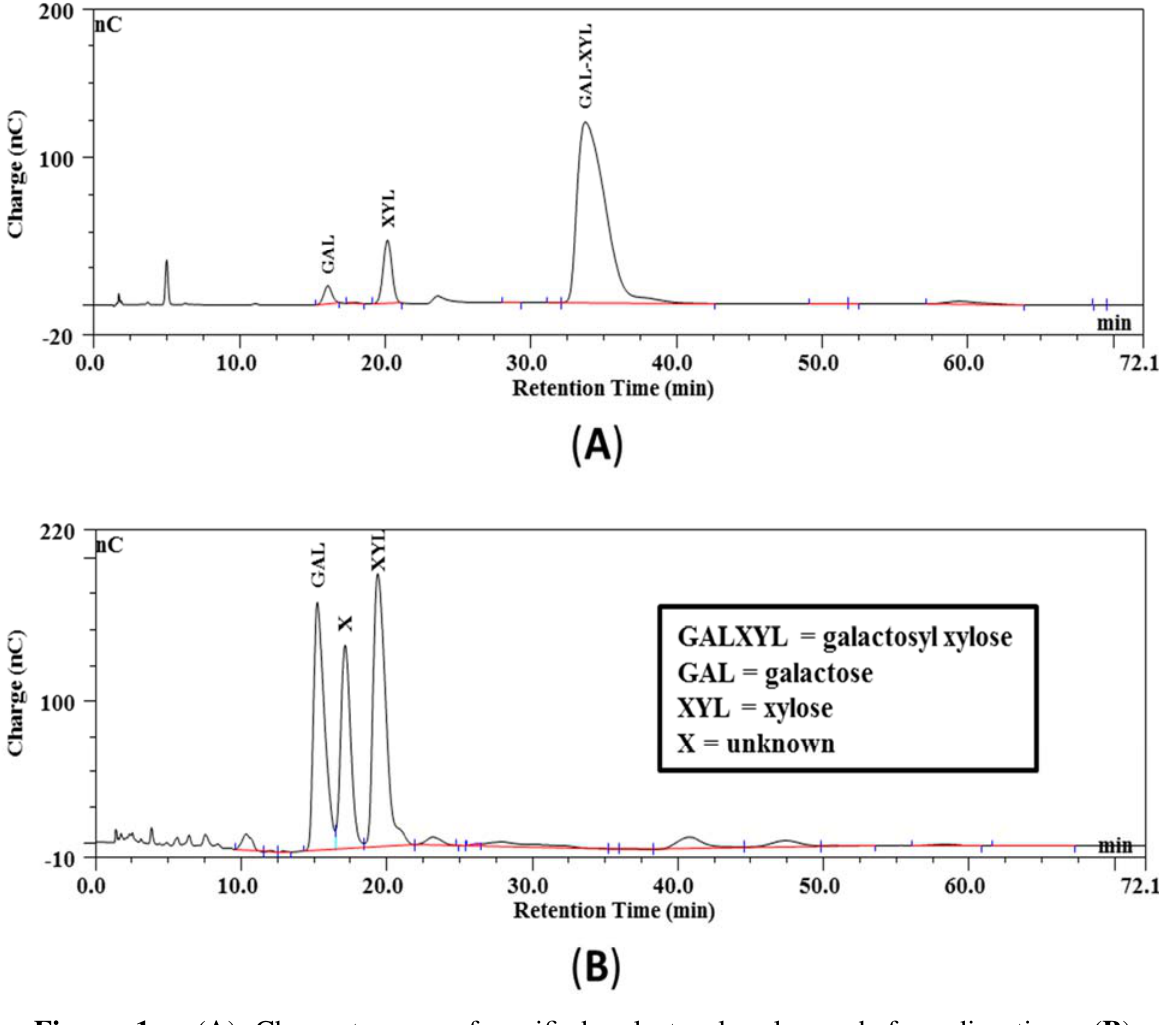
Figure 1. ( A ) Chromatogram of purified galactosyl xylose: before digestion; ( B )